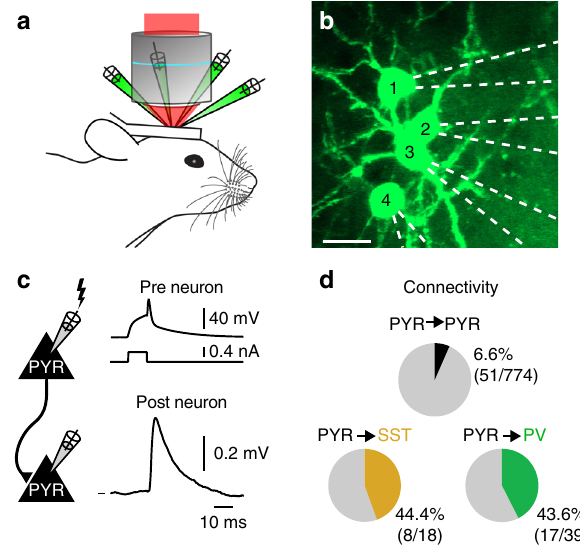
Fig. 1 In vivo monosynaptic excitatory connectivity. a Schematic representation of the experimental setup for multiple two-photon targeted whole-cell patch clamp recordings in vivo. Adapted from ref. 16 . b Example in vivo two-photon image of four simultaneously recorded pyramidal neurons fi lled with Alexa 594 (pseudo-colored). Scale bar, 20 µ m. c Cartoon schematic and example excitatory connection between two PYR neurons. To identify a monosynaptic connection, subthreshold responses in putative postsynaptic neuron were averaged (bottom) in response to single action potentials triggered via intracellular current injection in the putative presynaptic neuron (top). V m mark shows − 60.2 mV. d Pie charts showing the proportion of tested connections that were connected from PYR to PYR (black), PYR to PV (green), and PYR to SST (orange) and unconnected (gray), measured during DOWNstate (see